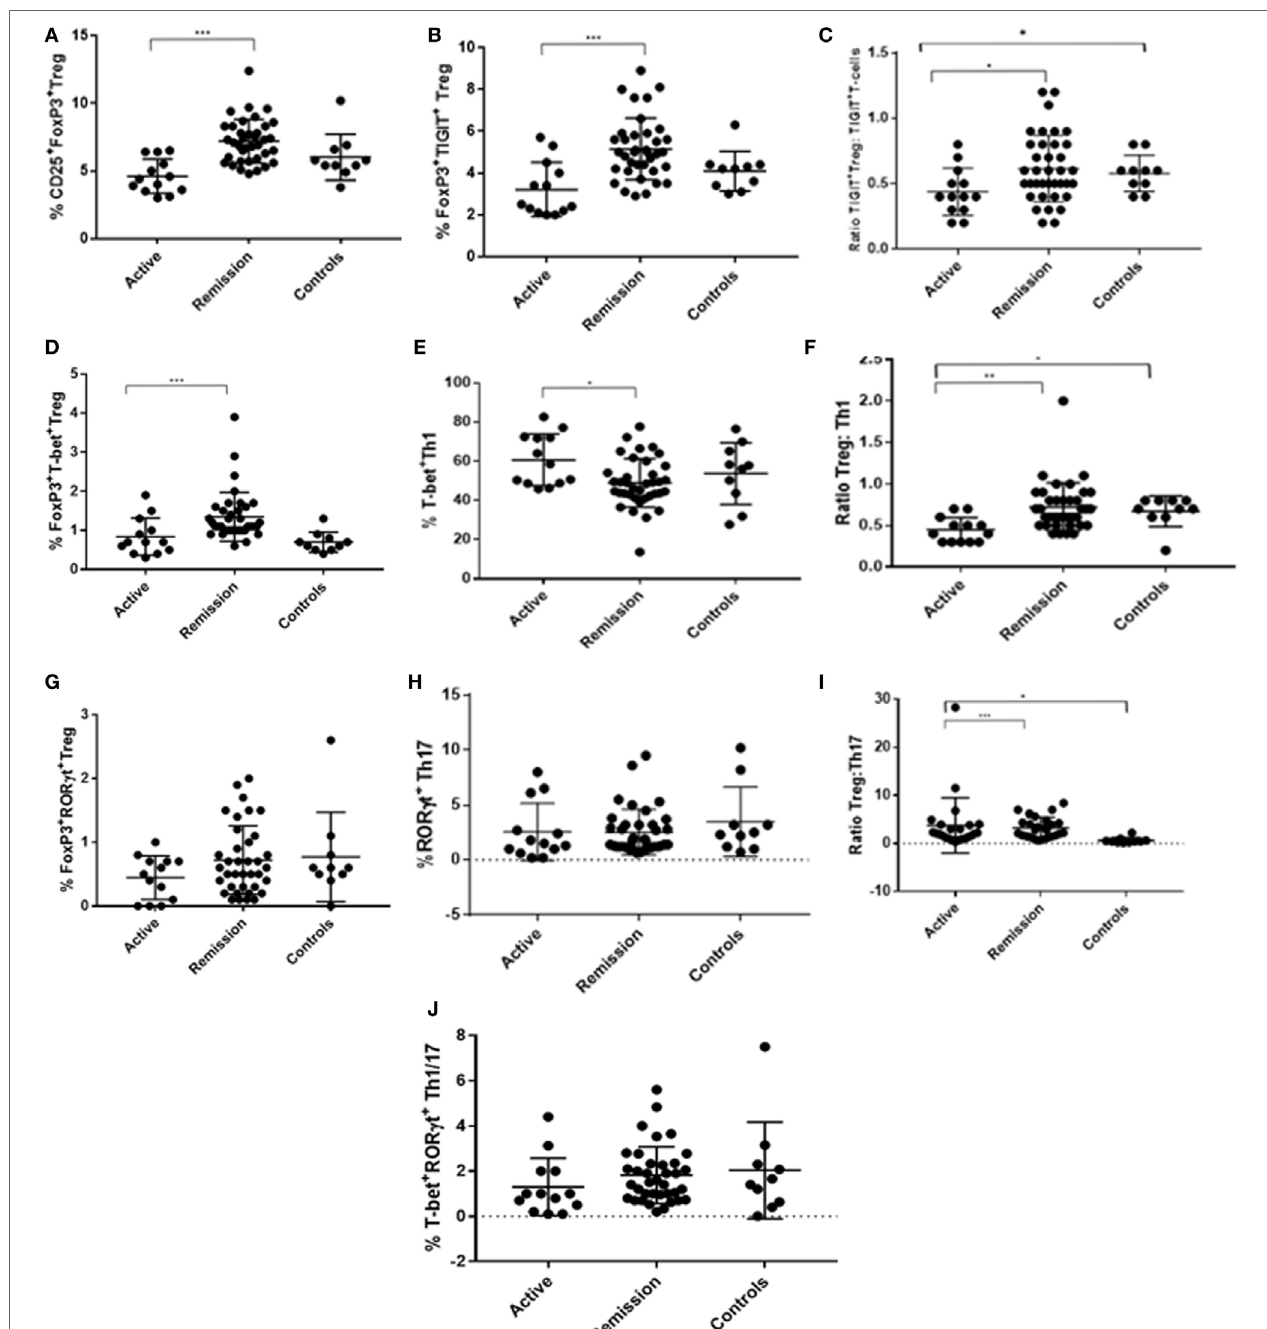
FigUre 4 | Dot plots showing flow cytometry analysis results (% frequency or ratio) of peripheral blood levels of T-regulatory cell (Treg), Th1, and Th17 subtypes in CD3 + CD4 + T-cell compartment, with comparisons across the three subject groups (active, remission, and controls). (a) % CD25 + FoxP3 + Treg. (B) % FoxP3 + TIGIT + Treg. (c) Ratio of FoxP3 + TIGIT + Treg to TIGIT + FoxP3 − T-cells. (D) % FoxP3 + T-bet + Treg. (e) % T-bet + Th1. (F) Ratio of Treg to Th1. (g) % FoxP3 + ROR γ t + Treg. (h) % ROR γ t + Th17. (i) Ratio of Treg to Th17. (J) % T-bet + ROR γ t + “double positive” Th1/Th17.